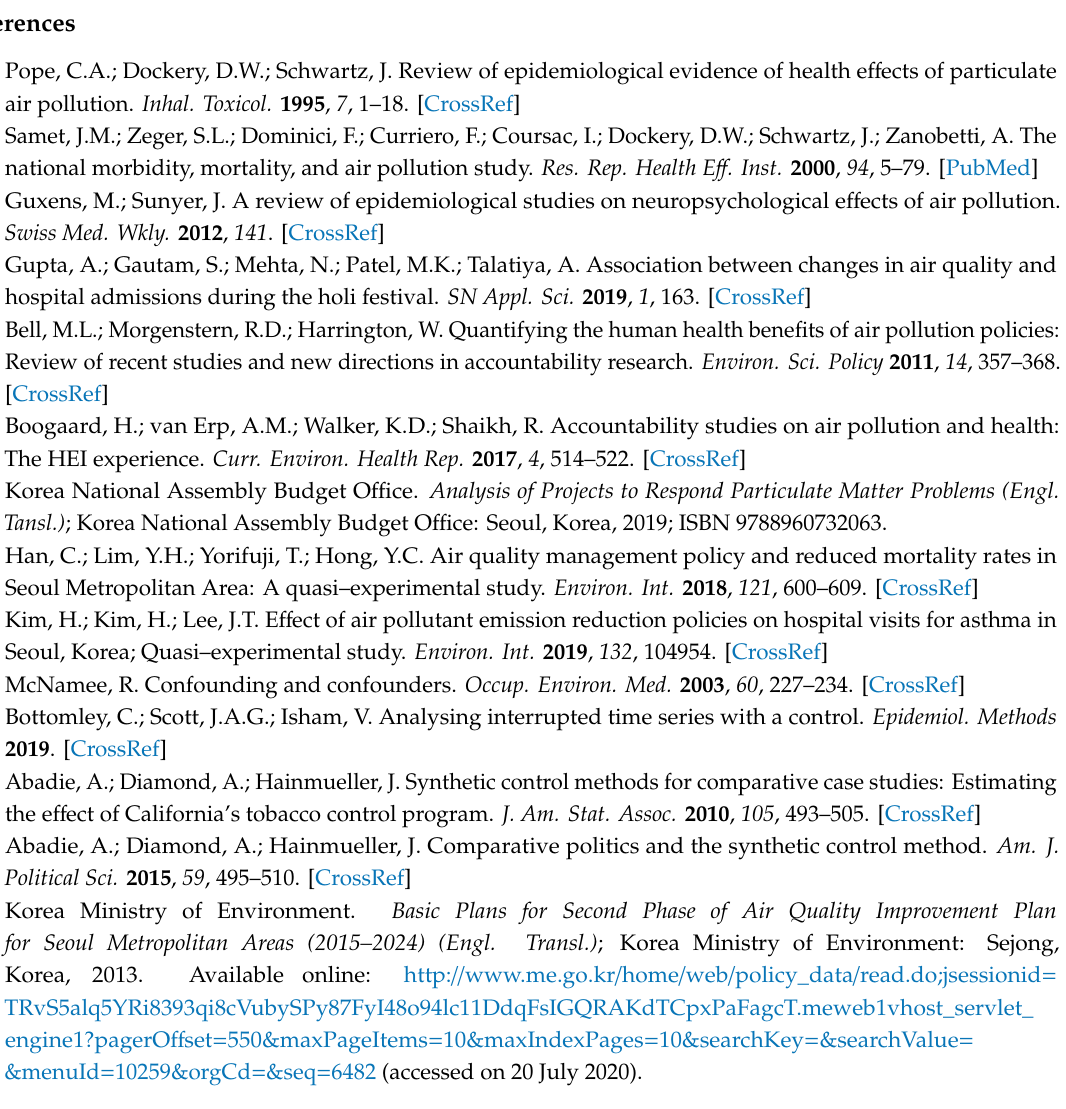
Table S1: Air-quality regulations in Seoul metropolitan area (SMA) after 2005, Table S2: Weights of the potential control groups, Table S3: Results from sensitivity analyses using direct adjustment of the counterfactual mortality rate, Table S4: Results from sensitivity analyses reconstructing synthetic controls (SC), Table S5: Results from sensitivity analyses with di ff erent time point of the health e ff